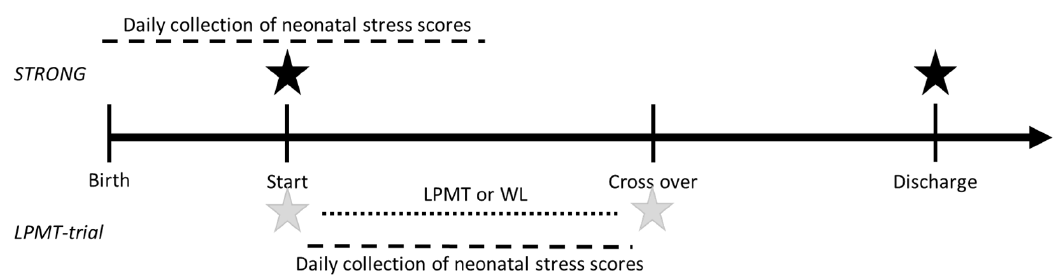
Figure 1. Study procedures of the “Stress and Outcomes in NICU Graduates (STRONG)” and Live-Performed Music Therapy Trial (LPMT trial). Black stars represent the timing of the State and Trait Anxiety Inventory in the STRONG study. Grey stars represent the timing of the State and Trait Anxiety Inventory in the LPMT trial.